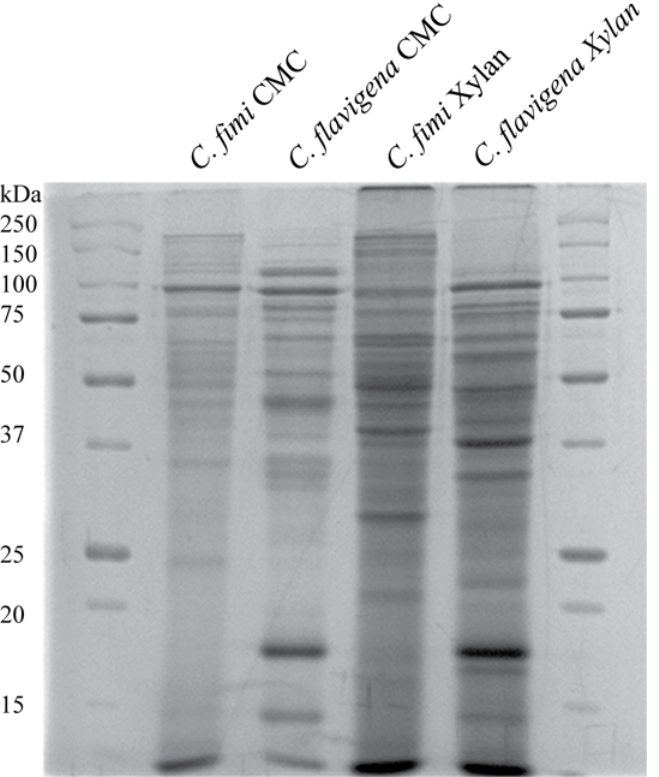
Fig 1. Example of the SDS-PAGE that was used for GelLC analysis of supernatant proteins. Lanes 1 and 6: BioRad All-blue SDS-PAGE standards; Lane 2: proteins recovered from the supernatant of CMC grown C . fimi ATCC484 cells; Lane 3; proteins recovered from the supernatant of CMC grown C . flavigena ATCC482 cells; Lane 4: proteins recovered from the supernatant of soluble xylan grown C . fimi ATCC484 cells; Lane 5: proteins recovered from the supernatant of soluble xylan grown C . flavigena ATCC482 cells.